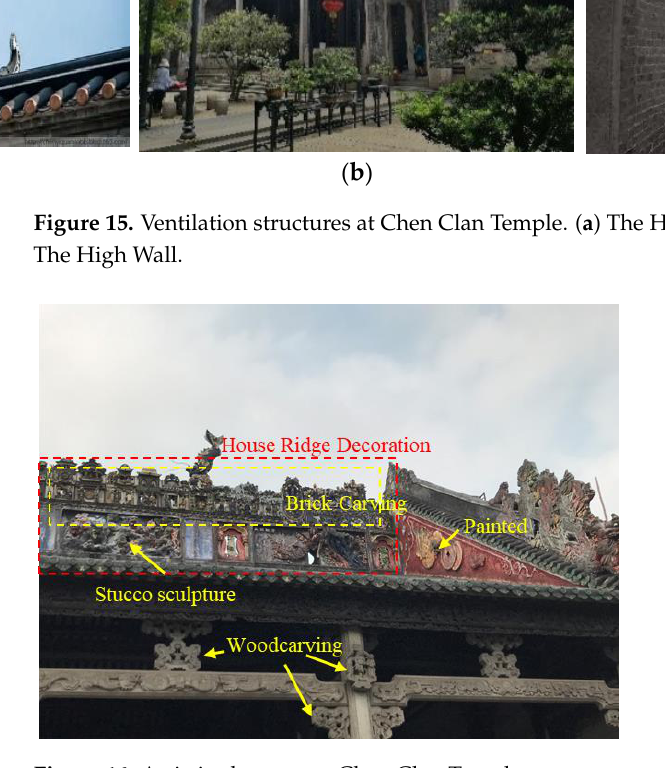
Figure 17. The male lion at Chen Clan Temple.